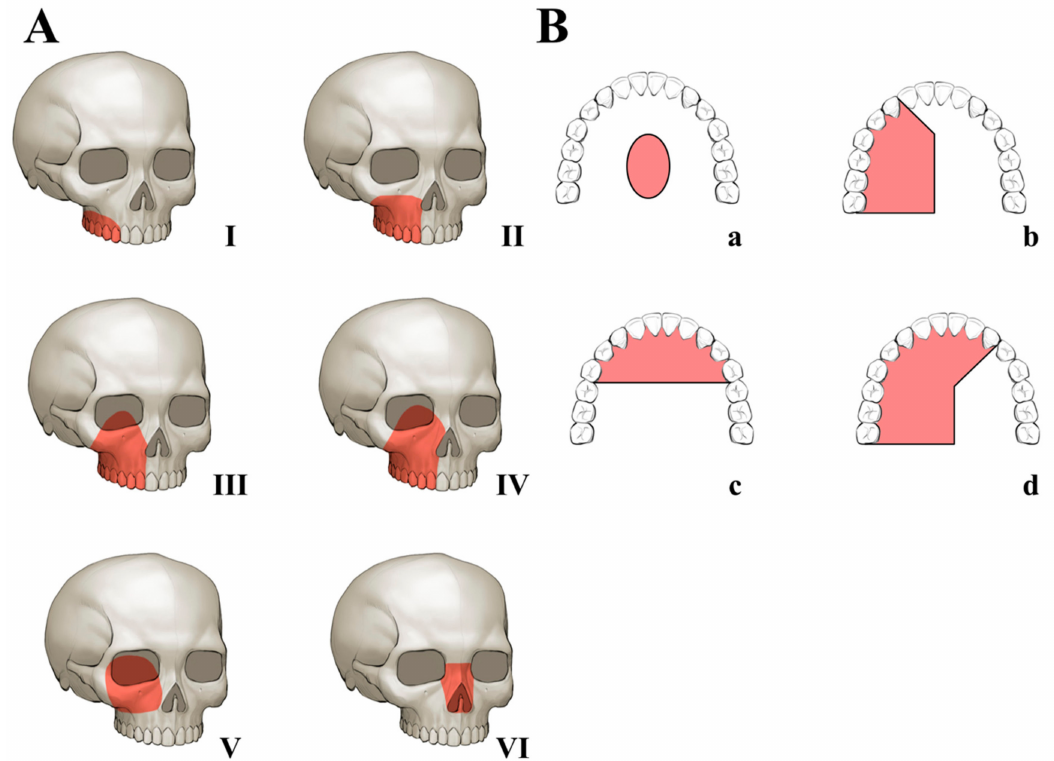
Figure 1. Brown’s revised classification of maxillary and midfacial defects [4]: ( A ) Vertical classification: I. maxillectomy not causing an oronasal fistula; II. not involving the orbit; III. involving the orbital area with orbital retention; IV. with orbital exenteration; V. orbitomaxillary defect; and VI. nasomaxillary defect. ( B ) Horizontal classification: a. palatal defect only, not involving the dental alveolus; b. less than or equal to 1 / 2 unilateral; c. less than or equal to 1 / 2 bilateral or transverse anterior; and d. greater than 1 / 2